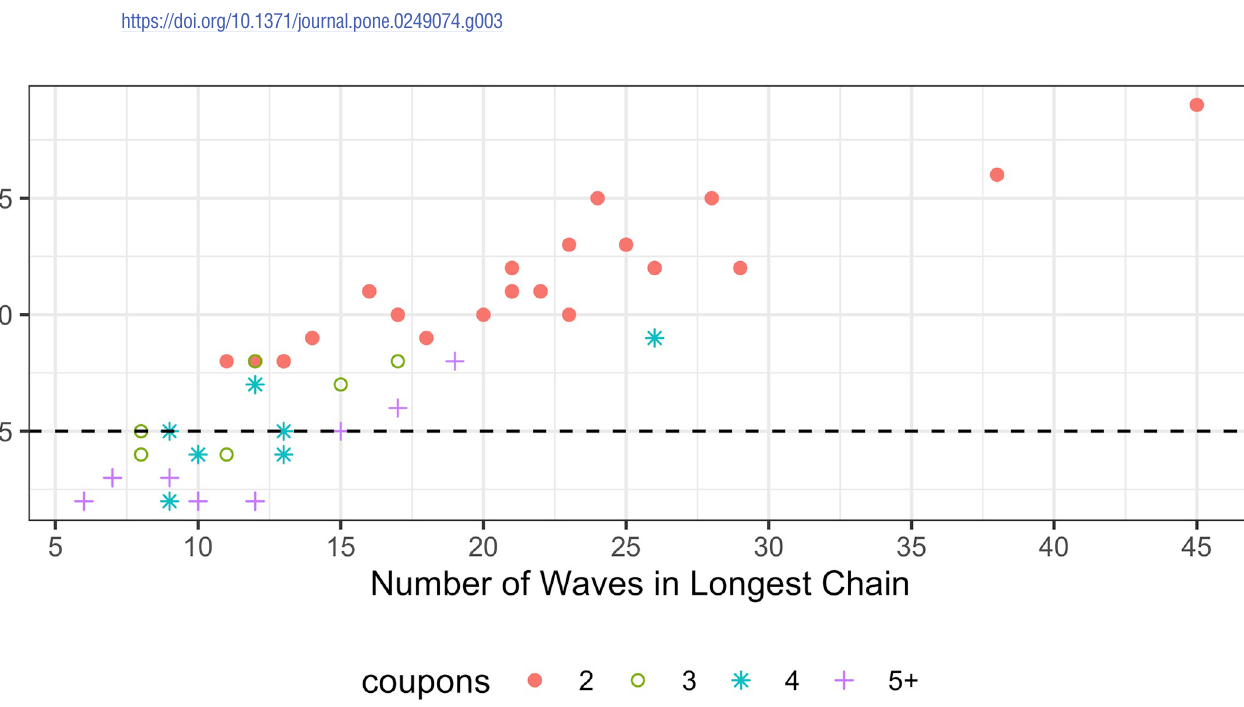
PLOS ONE | https://doi.org/10.1371/journal.pone.0249074 April 15, 2021 13 /